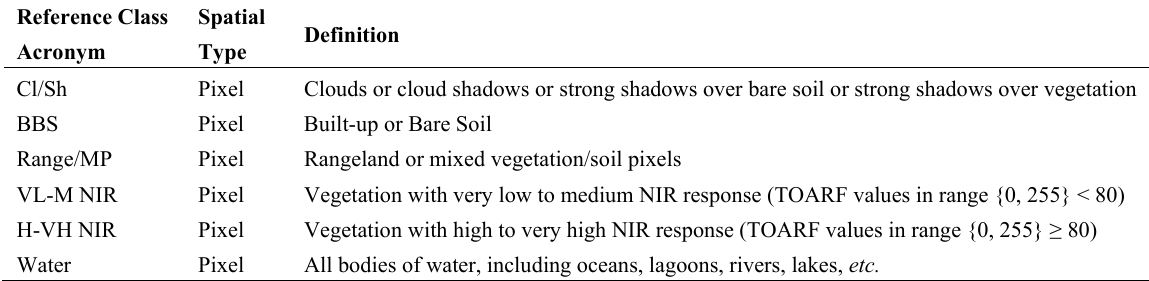
Table 5. Reference class definitions and acronyms for the IRS-P6 LISS-3 test image, 23.5 m resolution, see Figure 1a.